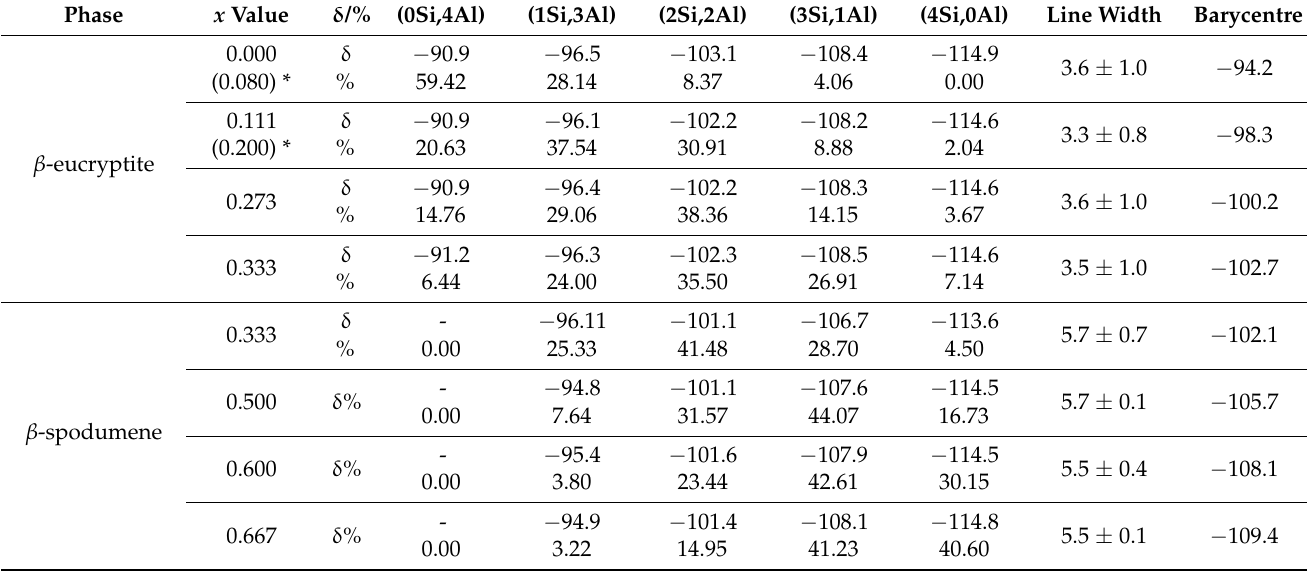
Deconvolution of the 29 Si MAS NMR spectra of β -eucryptite and β -spodumene selected samples.